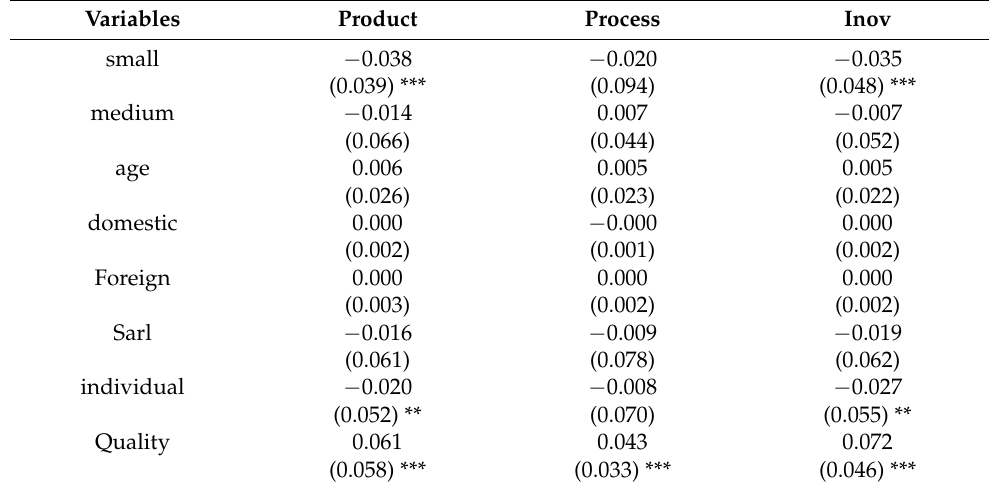
Table 4. Probit regression: the determinants of